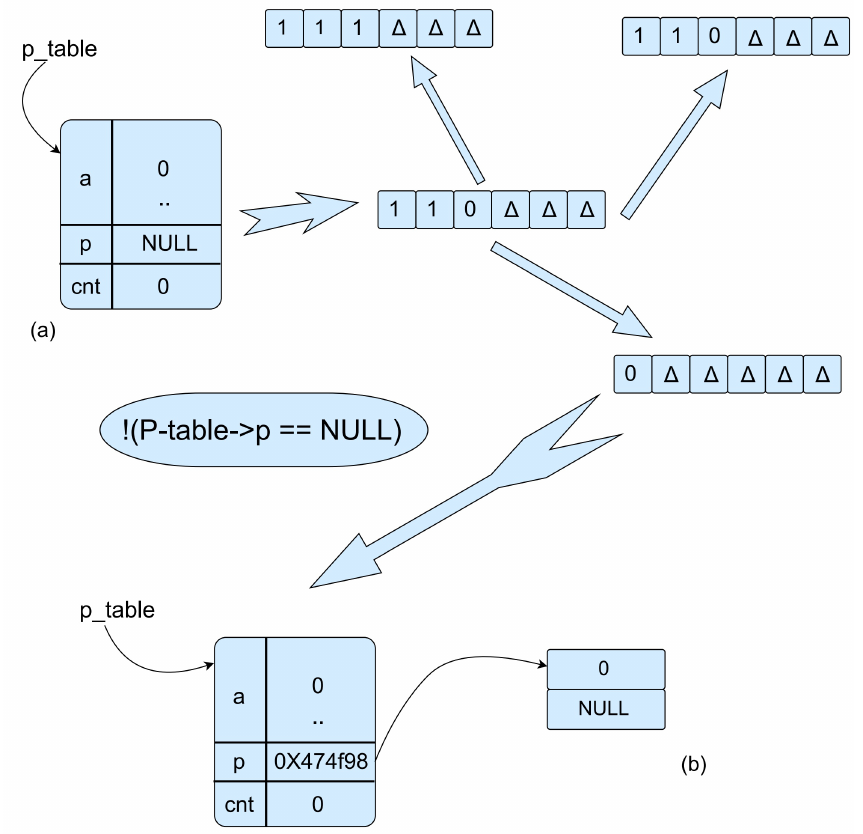
Figure 3. The search process. ( a ) shows a real program path. ( b ) shows a test case generated for executing of the chosen